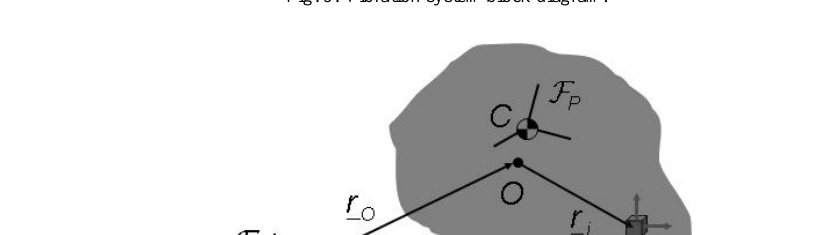
Fig. 3. Vibration system block diagram.